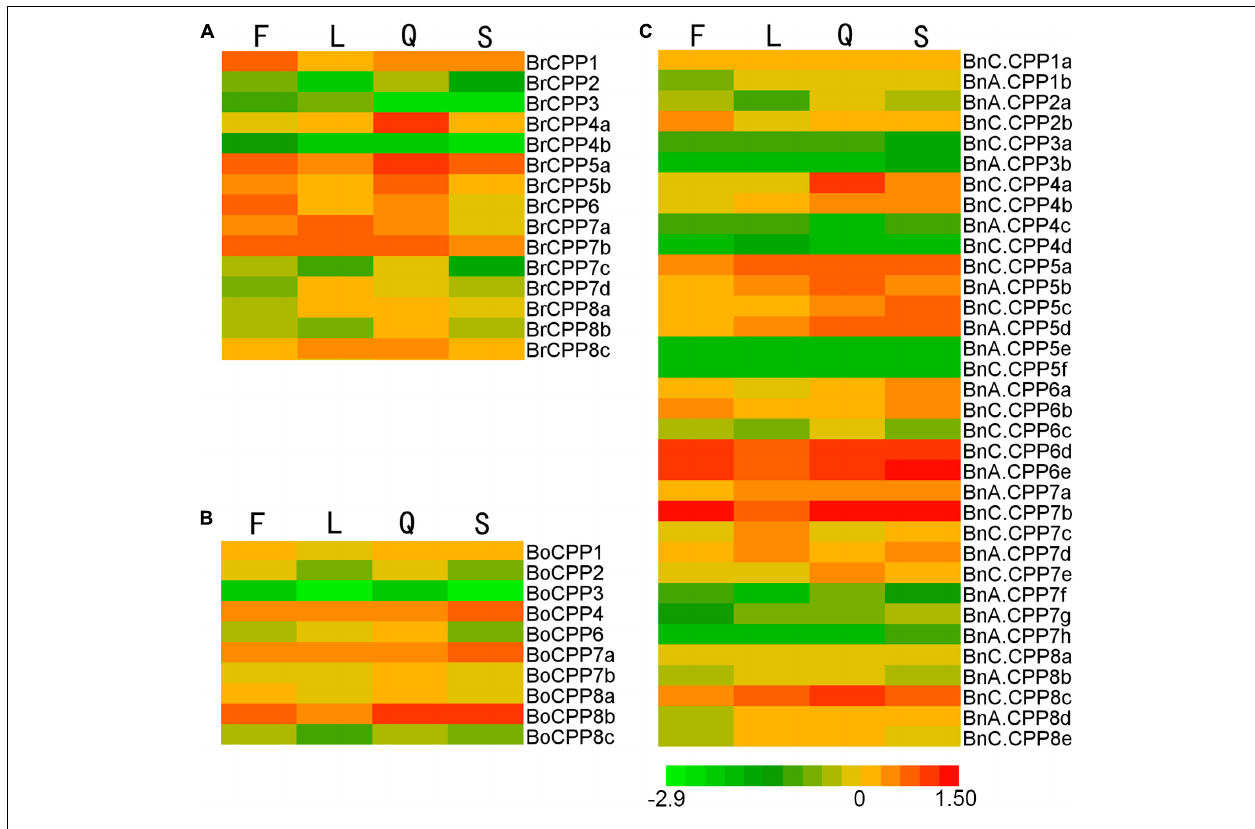
FIGURE 6 | Expression patterns of CPP genes in flowers (F), leaves (L), siliques (Q) and stems (S) from B. rapa (A) , B. oleracea (B) , and B. napus (C) .